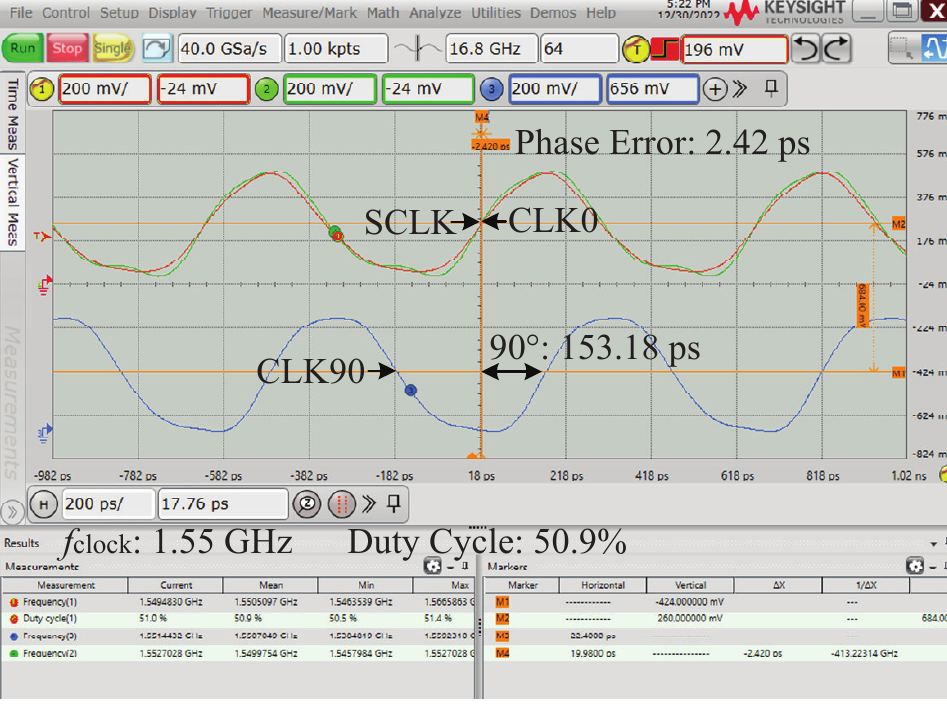
Figure 18. The chip testing results of proposed four-phase DLL with de-skew circuit at f clock = 1.55